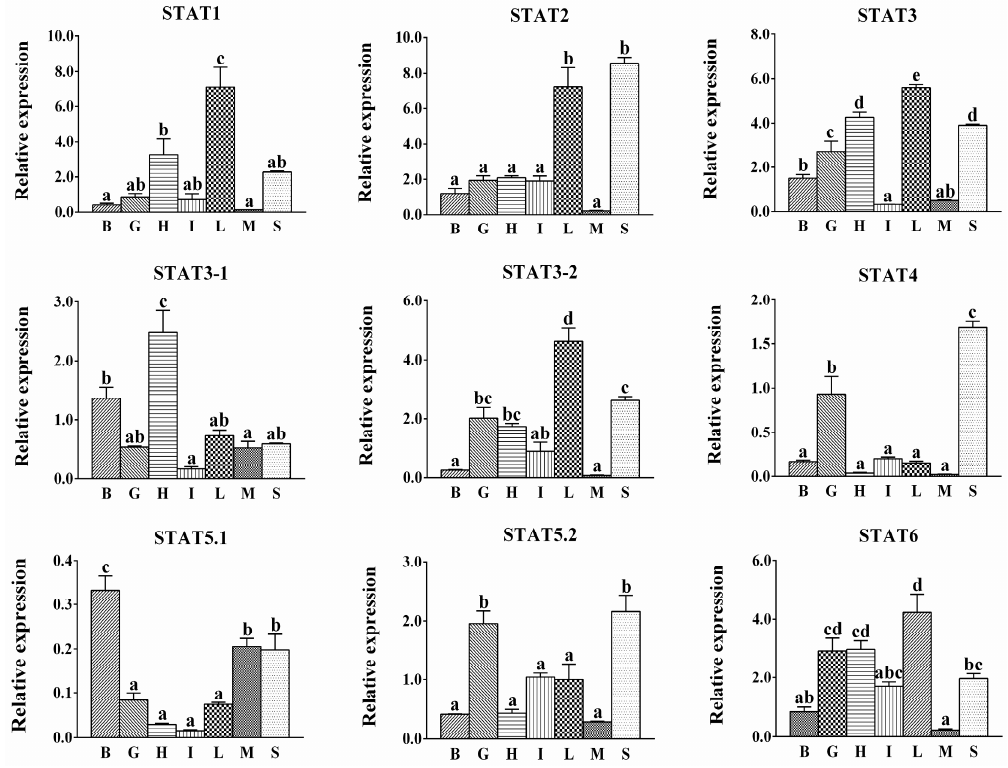
Figure 3. Quantitative PCR (Q-PCR) analysis for expression of STATs across brain (B), gill (G), heart (H), intestine (I), liver (L), muscle (M) and spleen (S) of S. hasta . Data (mean ± SEM, n = 6 specimens, mixed sexes) were expressed relative to expression of housekeeping gene ( β -Actin and 18 s rRNA ). The expression of STAT5.2 in liver was arbitrarily set as 1, for calculation of relative expression in other tissues. Bars that do not share the same lowercase letter mean significant difference among different tissues ( p < 0.05).